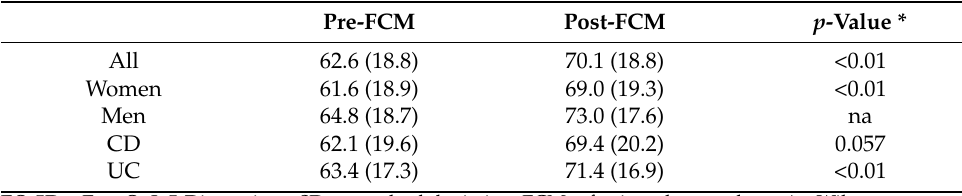
Table 5. Mean EQ-5D visual analogue scores